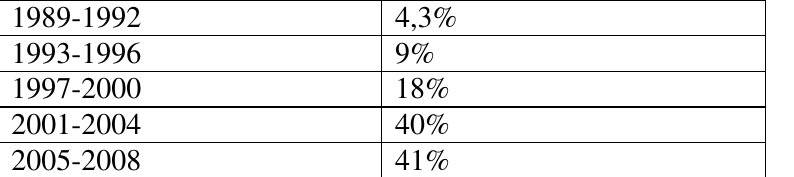
Table 1: Percentage of Brazilian cities with more than 100.000 inhabitants with a PB